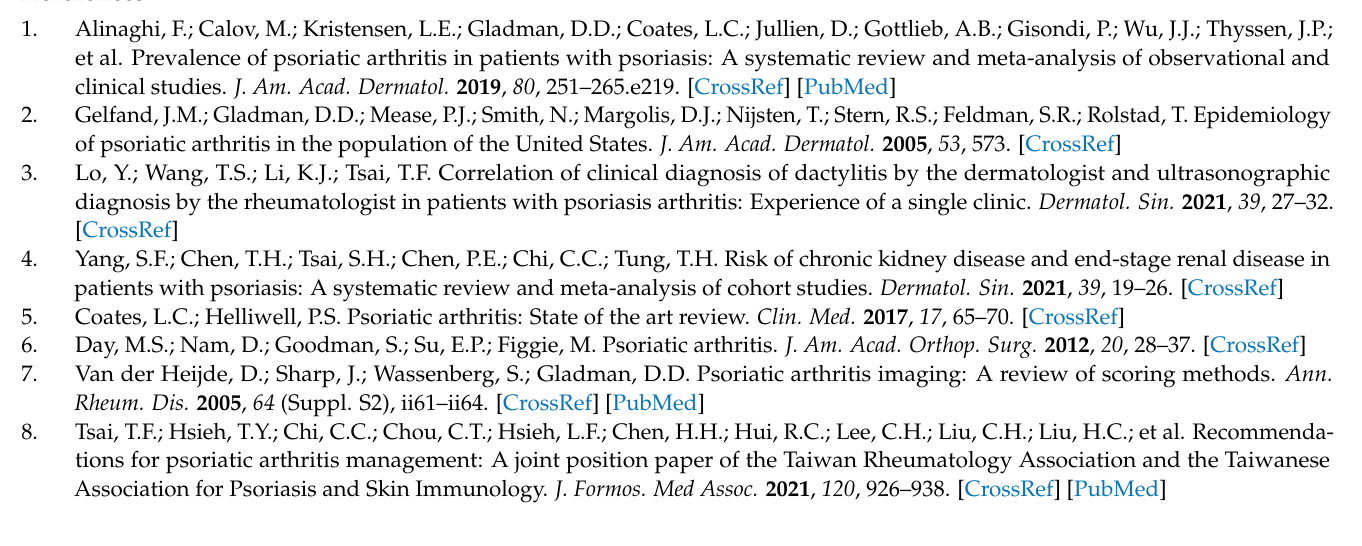
League table of treatment response: analysis based on radiographic non-progression. Table S3: League table of treatment response: analysis based on changes in the total radiographic score. Table S4: League table of treatment response: analysis based on discontinuation due to adverse events of psoriatic arthritis patient receiving bDMARDs. Figure S1: Risk of bias, presented with the Cochrane Collaboration’s Assessment Tool. Figure S2: Funnel plot for radiographic non-progression of psoriatic arthritis patient receiving bDMARDs. Figure S3: Funnel plot for changes in the total radiographic score of psoriatic arthritis patient receiving bDMARDs. Figure S4: Funnel plot for discontinuation due to adverse events of psoriatic arthritis patient receiving bDMARDs. Figure S5: Egger’s test for radiographic non-progression. Figure S6: Egger’s test for change in the total radiographic score. Figure S7: Egger’s test for discontinuation due to adverse